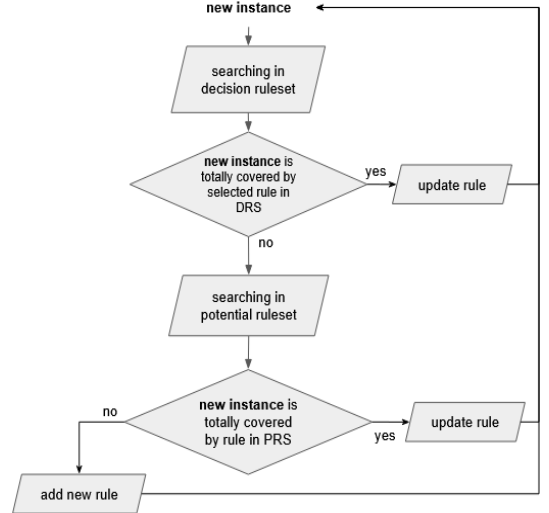
Figure 1. High level flowchart of IDRA.